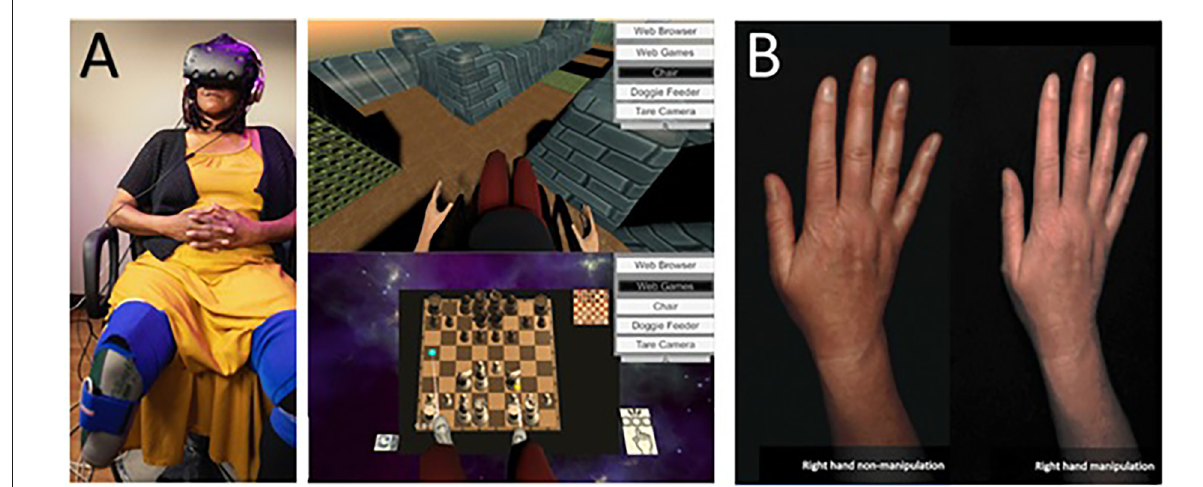
FIGURE2 (A) Lower limb amputee patient using an immersive system and their view of VR games used in the treatments. Note the visual illusion of having two intact lower limbs seen from a first-person perspective. Taken from Ambron, E. et al. Virtual reality treatment displaying the missing leg improves phantom limb pain: a small clinical trial. (2021) Neurorehabilitation and Neural Repair, 35(12), 1100-1111. doi: 10.1177/15459683211054164. Published October 27, 2021, by SAGE. © The Authors. (B) Example of illusory hand manipulation using immersive virtual reality in a patient with CRPS. Taken from Lewis, J. S. et al. (2021). Visual illusions modulate body perception disturbance and pain in Complex Regional Pain Syndrome: A randomized trial. European Journal of Pain , 25(7), 1551-1563. doi: 10.1002/ejp.1766. Published March 23, 2021, by Wiley. © The